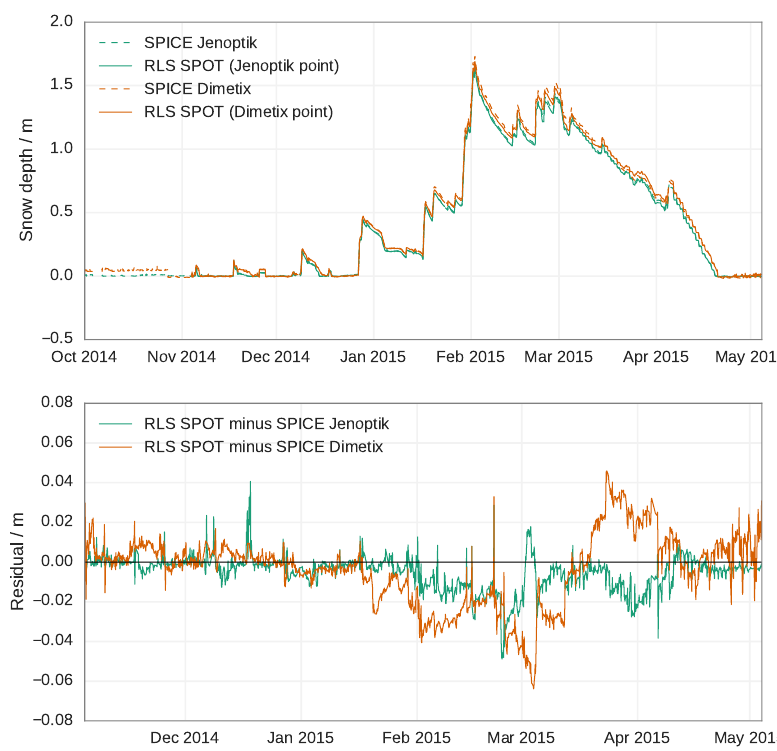
Figure 7. Evaluation of the RLS spot mode against SPICE laser meters at Col de Porte. Top panel shows the depth, bottom panel shows differences between sensors.